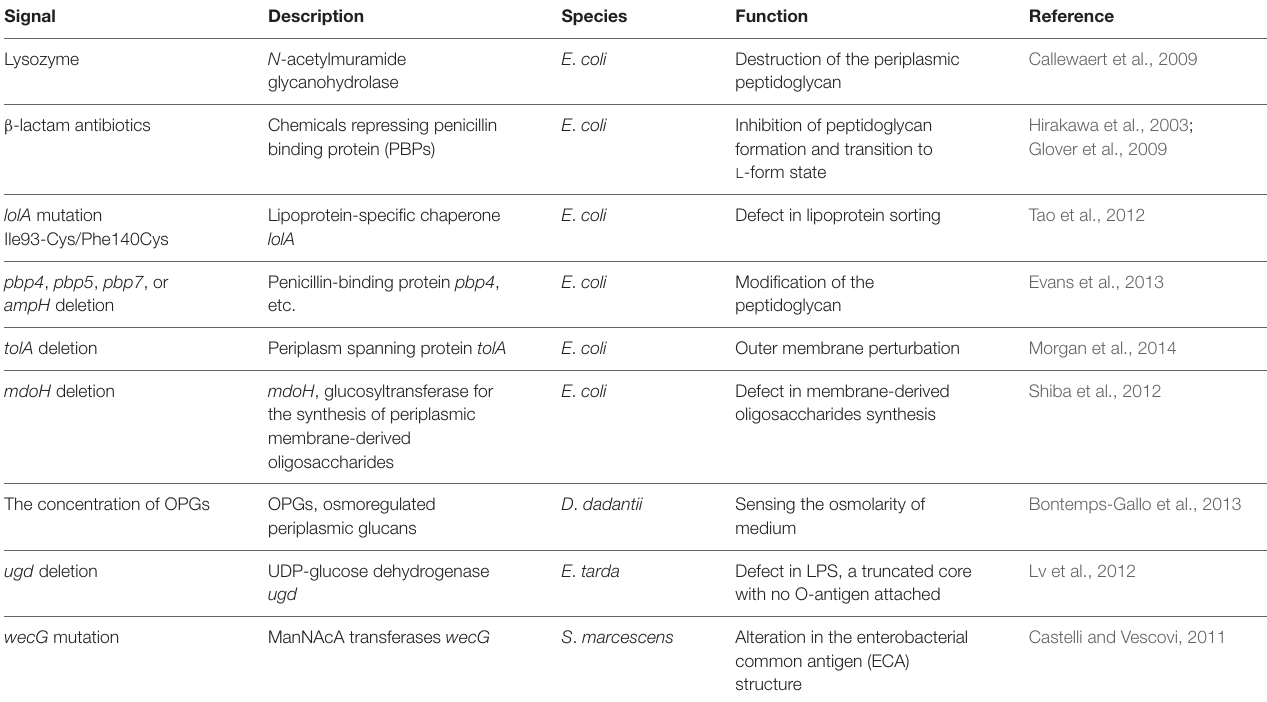
TABLE 2 | Extracellular or intracellular signals that cause envelope stress and induce Rcs